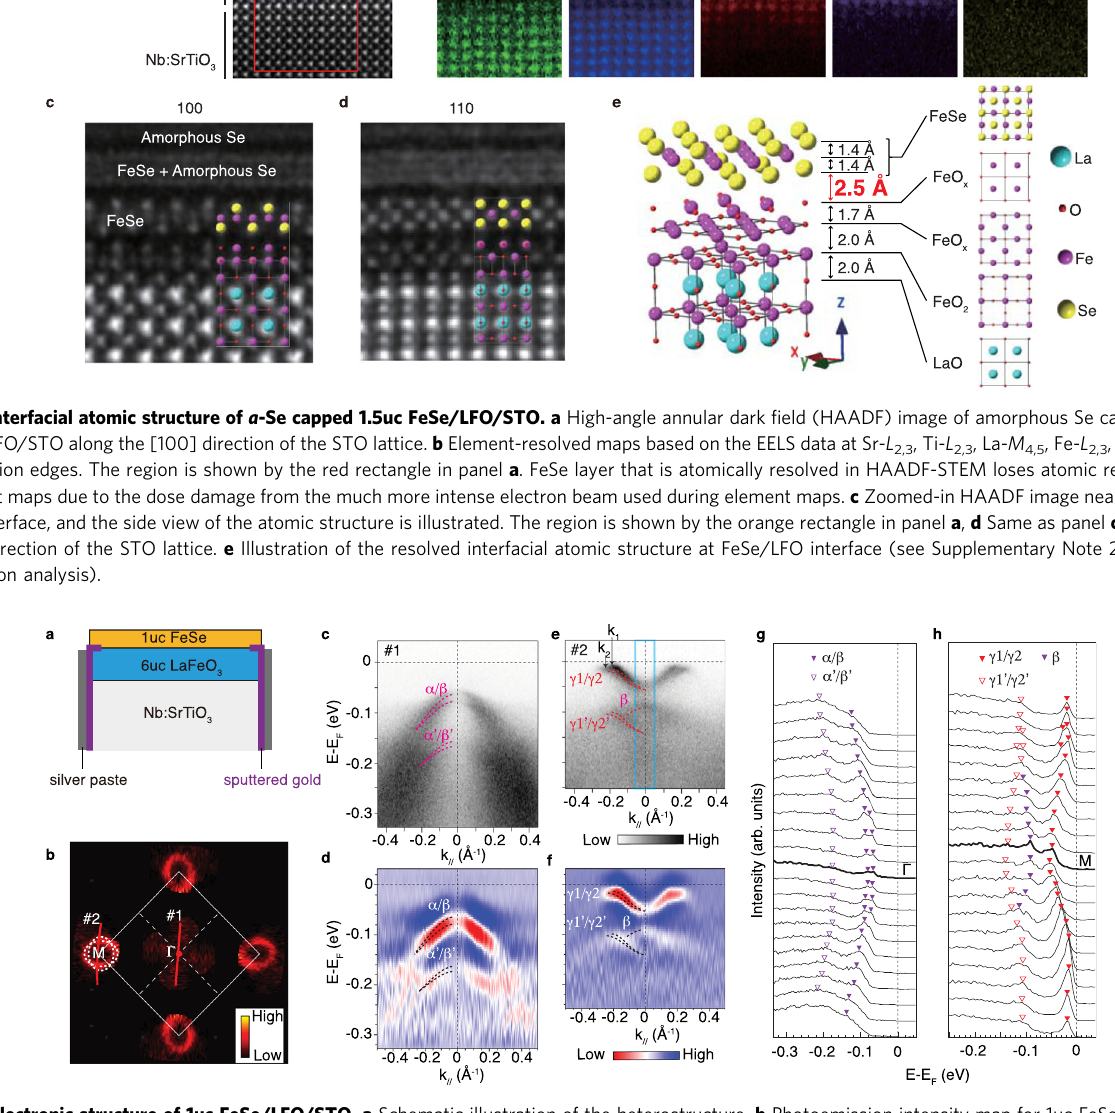
Fig. 2 Electronic structure of 1uc FeSe/LFO/STO. a Schematic illustration of the heterostructure. b Photoemission intensity map for 1uc FeSe/LFO/STO integrated over ( E F − 35 meV, E F + 15 meV). Data were measured at 6K with full photon fl ux of the Helium lamp, which shows a photoemission charging effect of ~10 meV (see Supplementary Fig. 5). With the integration energy window of ( E F − 35 meV, E F + 15 meV), it can represent the Fermi surface map under no charging effect. c , d Photoemission intensity ( c ), second derivatives of the photoemission intensity with respect to energy ( d ) along cut #1 in b . e , f Same as c , d , but along cut #2 in b . The dashed curves trace the band dispersions. g Energy distribution curves (EDCs) across Γ along cut #1. h Same as panel g , but across M along cut #2. Data in b – h were measured at 6K with 1/8 of the total photon fl ux of the Helium lamp, which eliminates the photoemission charging effect (see Supplementary Note of 1uc (Fig. 3a). The 1uc FeSe fi lms are weakly interconnected on each LFO terrace, which leads to poor grounding and charging effect during photoemission measurements. The spectra of 1uc FeSe/LFO/STO were taken using reduced photon fl ux to elim- inate charging effect (Supplementary Note 3). Figure 3b shows the symmetrized photoemission spectrum of 1uc FeSe/LFO/STO around M point at 6 K. The two electron bands γ 1 and γ 2 backbend near E F , a hallmark of the Bogliubov quasiparticle dispersion. The superconducting gap at k 1 ( Δ 1 ) of 1uc FeSe/LFO/ STO is 17 ± 2 meV. The 17 meV superconducting gap is